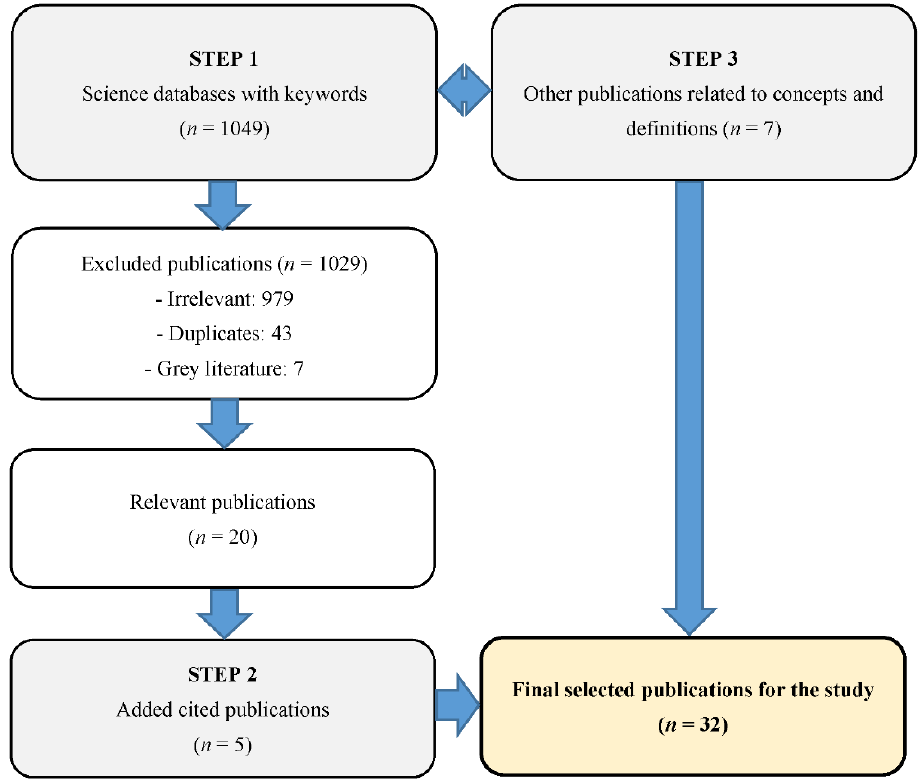
Figure 1. Research methodology.